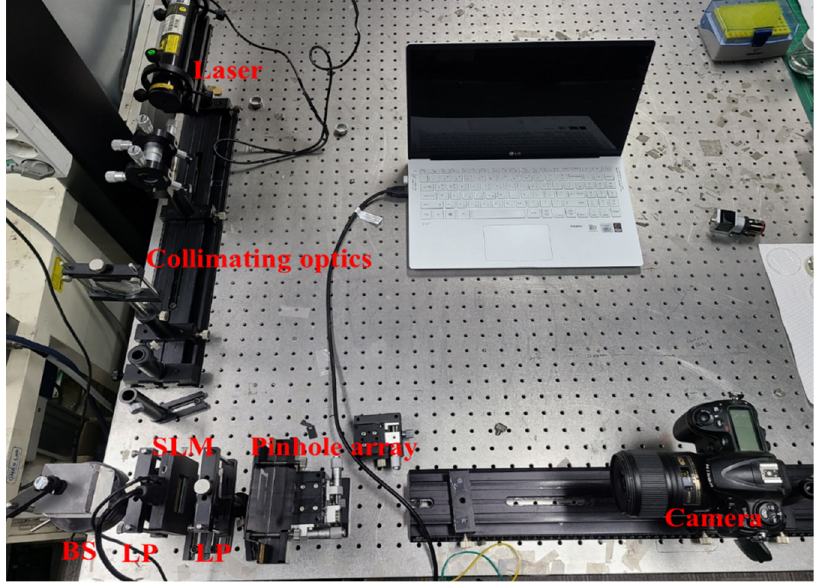
Figure 7. Optical configuration used in the experiment. (BS: Beam-Splitter, LP: Linear Polarizer).